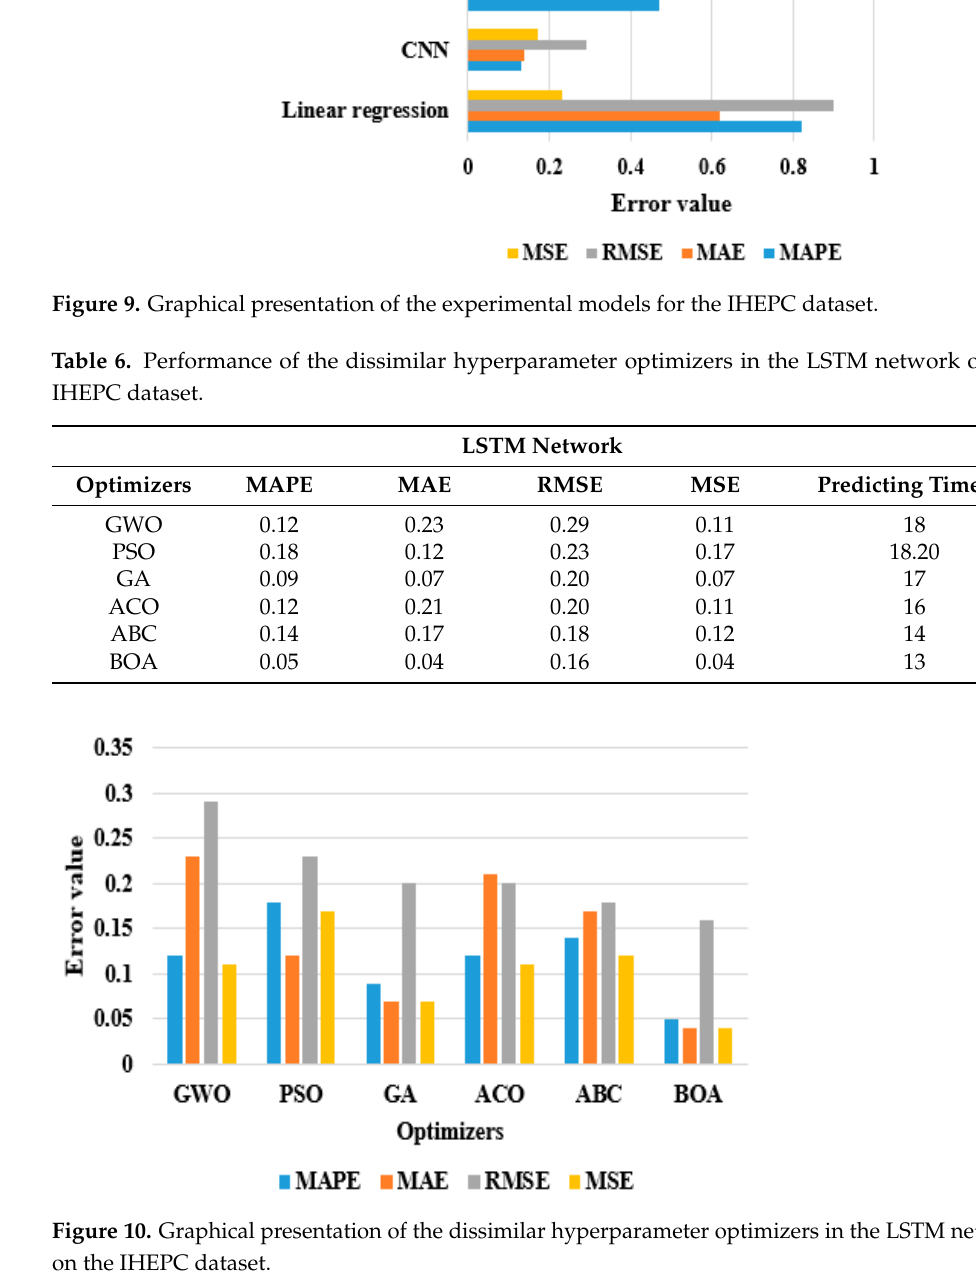
Figure 11. Fitness comparison of different optimizers achieved by varying the iteration number on the IHEPC dataset. The prediction performance of the metaheuristic-based BOA model for the AEP and IHEPC datasets are graphically presented in Figures 12 and 13. Through an examination of these graphs, the proposed metaheuristic-based BOA model was shown to generate effective prediction results in the EECP domain. Figure 12. Prediction performance of the proposed model for the AEP dataset .